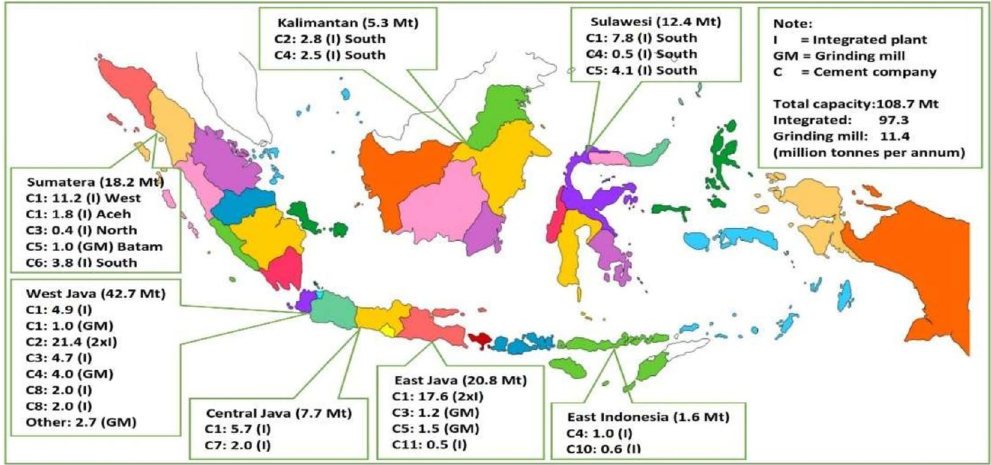
Figure 4. Market structure, cement supply, Indonesia, 2018 89,91 .